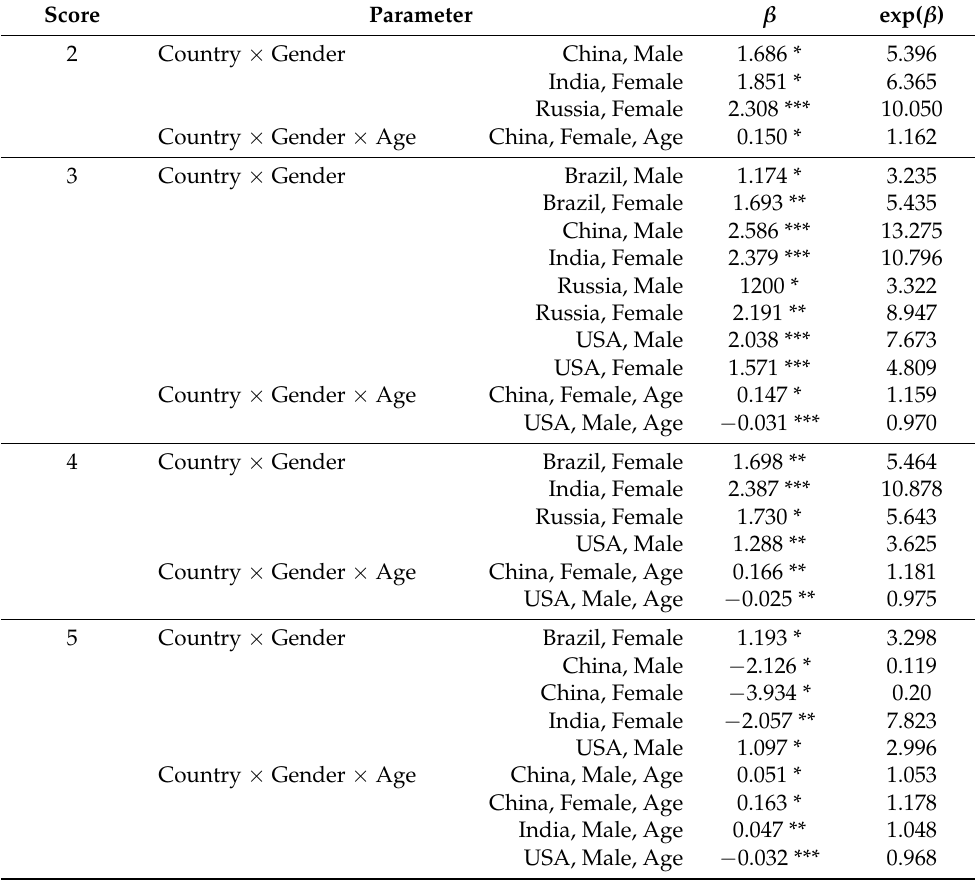
Table 4. Parameters of the multinomial logistic model fitted to the data. The scores given to the statement “ eating meat directly contributes to the suffering of animals, ” used as the dependent variable, are modeled function of the independent variables “Country”, Gender” and “Age” together with the interactions between these. Only significant ( p < 0.05) parameters are shown. Score 1 is used as a reference in the